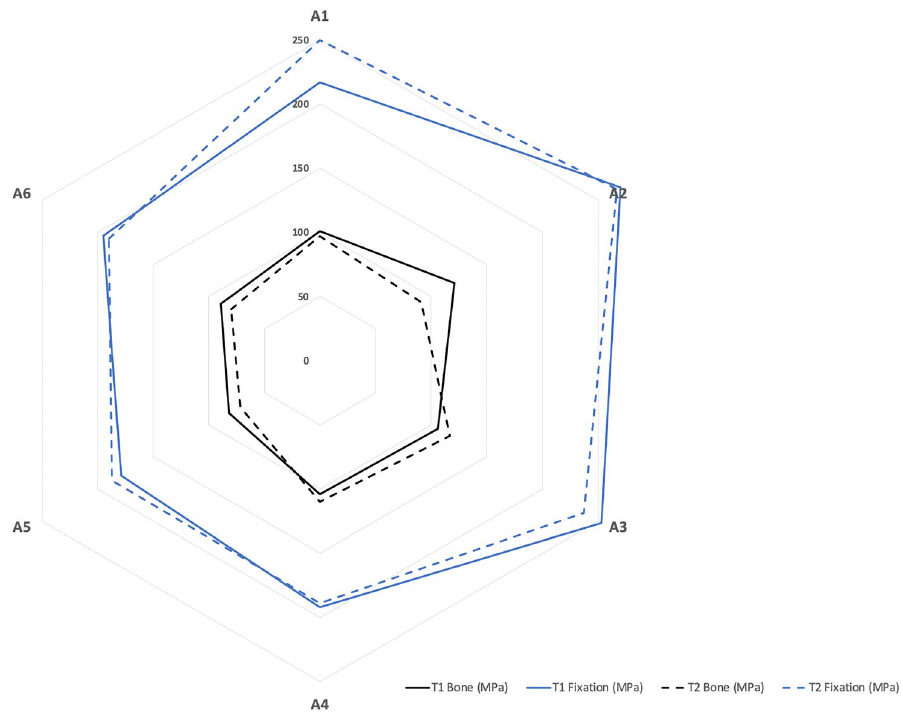
Figure 8. von Mises Stress peaks in bone and in fixations show the lowest stresses in the A5 configuration for both the T1 and T2 models.